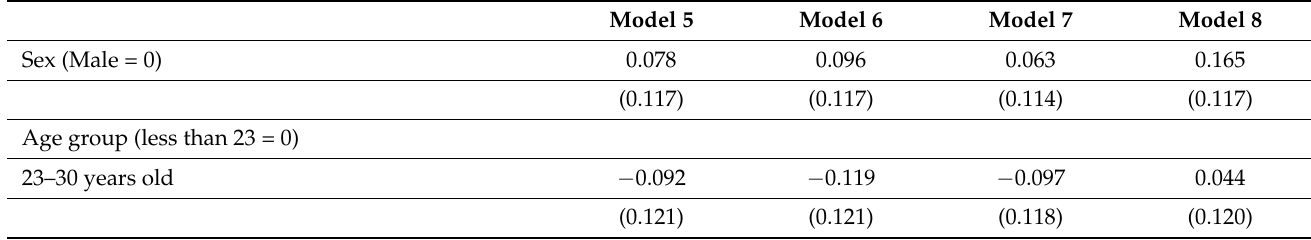
Table 5. Regression model of lockdown, social support, and learning behavior